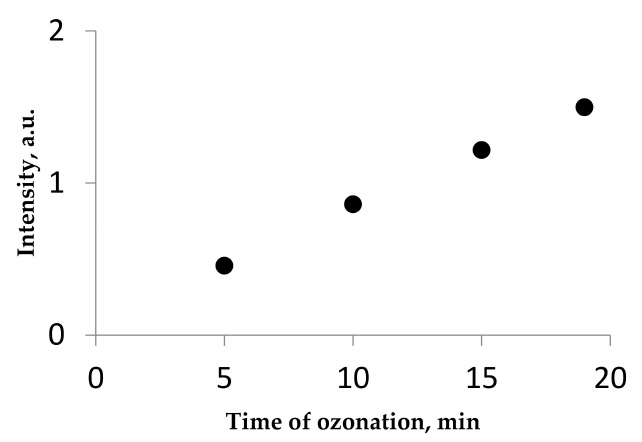
Figure 2. Dependence of the intensity of the UV absorption band at ~288 nm vs. time upon ozonation of decalin. T = 22 ◦ C. [O 3 ] = 100 mg/L. Optical path, 1 cm.